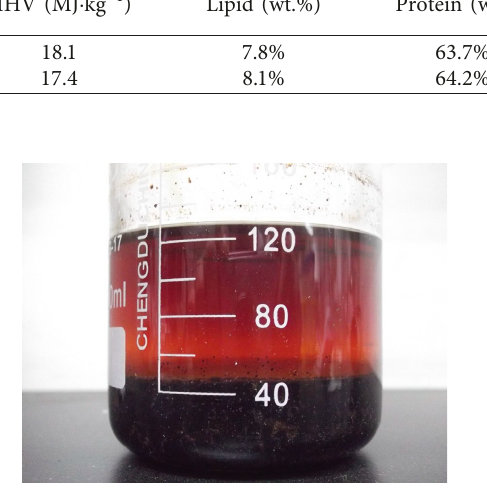
Figure 2: The reaction mixture with